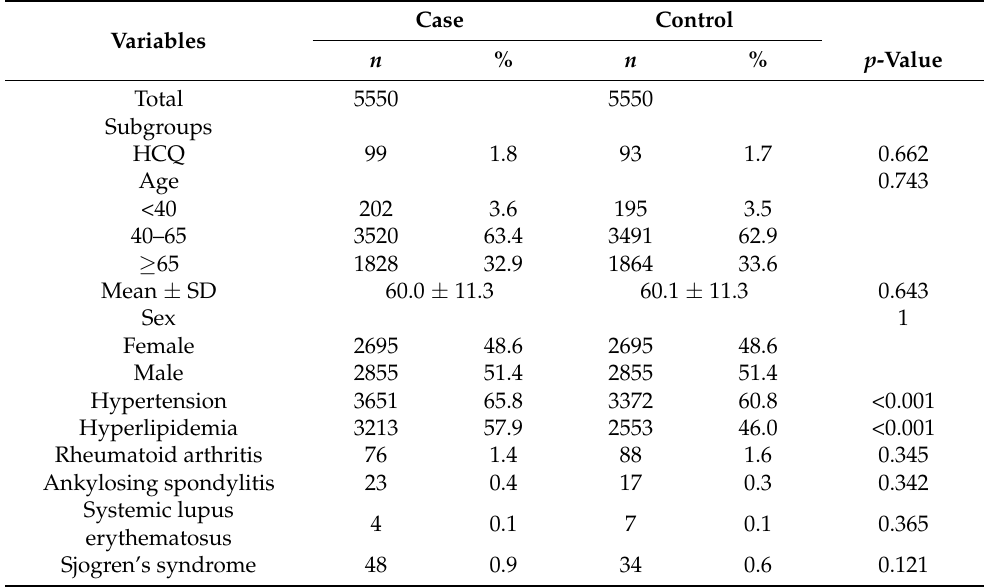
Table 1. Demographic characteristics of diabetic patients.